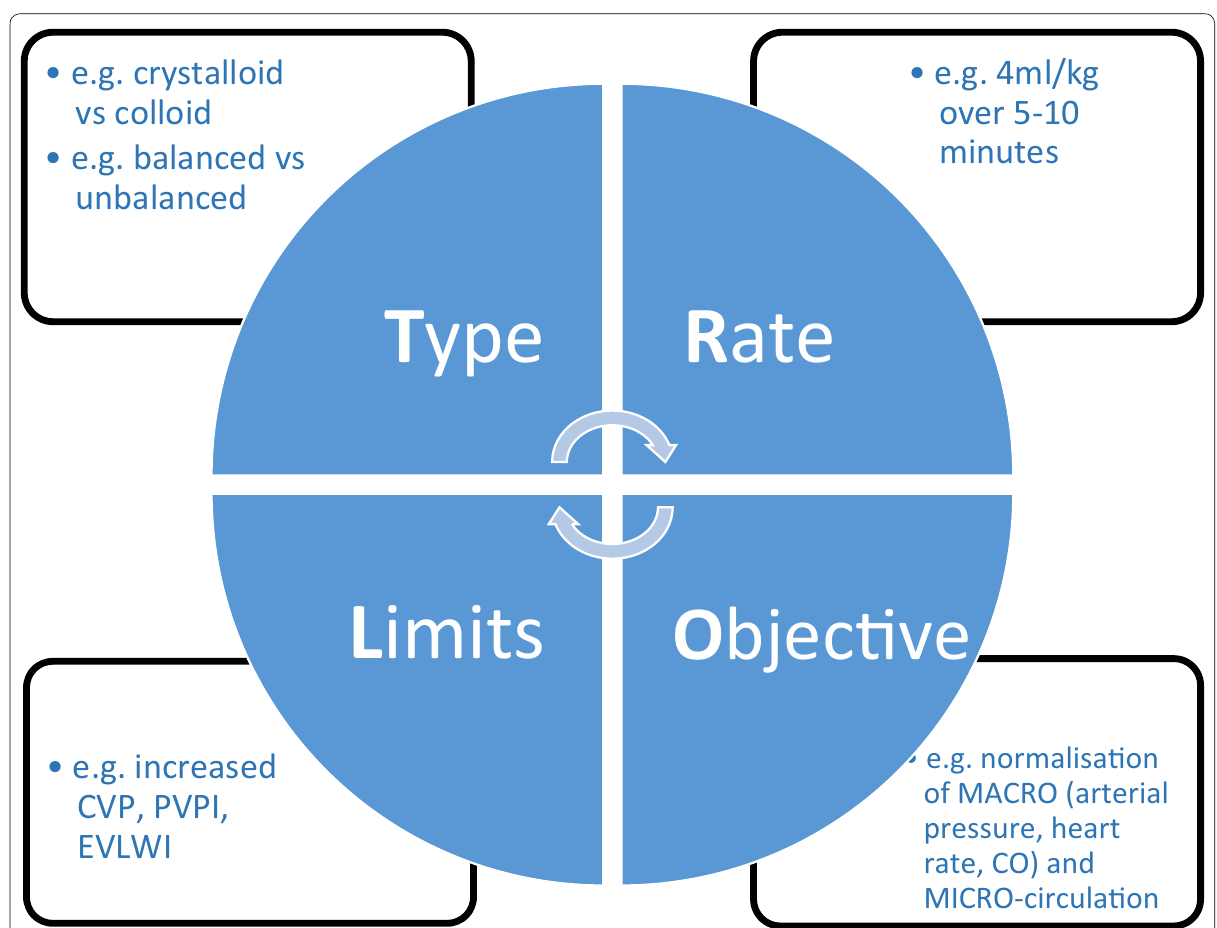
Fig. 2 The TROL mnemonic of fluid challenge: considerations for administration of a fluid bolus in critically ill patients. CO cardiac output; CVP central venous pressure; EVLWI extra vascular lung water index; PVPI pulmonary vascular permeability index (Adapted from Vincent and Weil